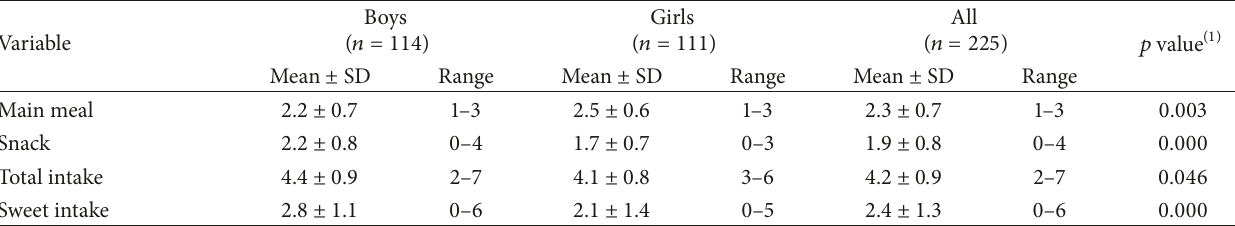
Table 1: Mean and standard deviation (SD) for main meal, snack, total intake, and sweet intake in Saudi schoolchildren (boys, girls). Boys Girls Variable ( 𝑛 = 114 ) ( 𝑛 = 111 ) Mean ± SD Range Mean ± SD Range Mean ± SD Range Main meal 2.2 ± 0.7